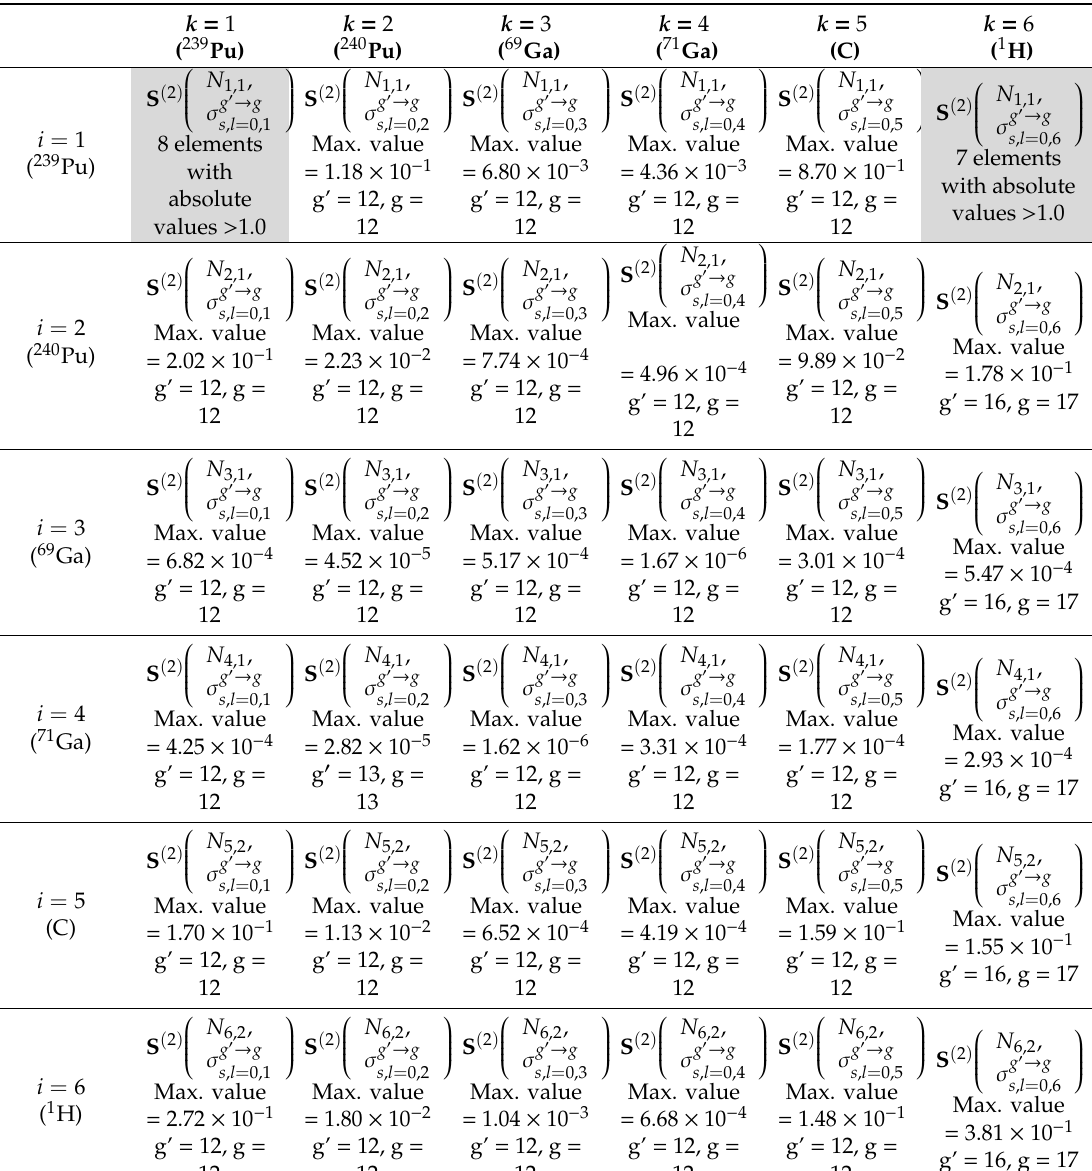
(cid:16) (cid:17) (cid:48) → g N i , m , σ g , for 2nd-order relative sensitivities of s , l = 0, k